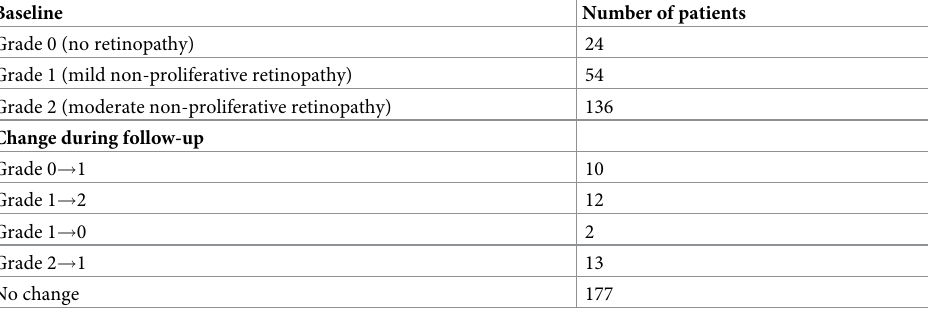
Table 2. Retinopathy grades at baseline and change in retinopathy grade during follow-up.